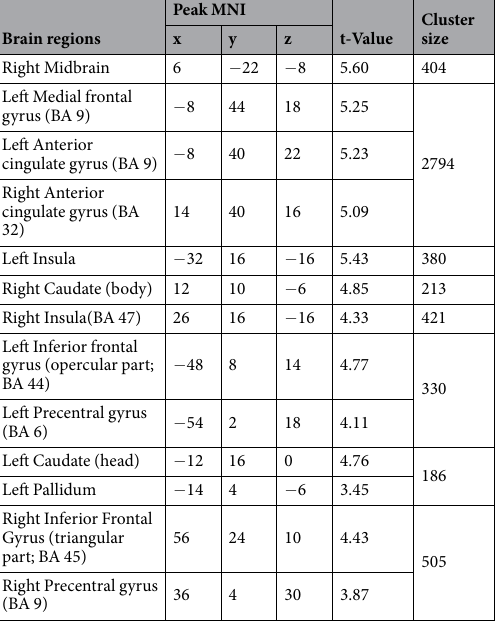
Table 2. Brain regions showing greater activation in choices of a slightly selfish offer (i.e., offering 40% or 30%) than a fair offer ( p < 0.001 uncorrected with FDR correction at the cluster level; BA, Brodmann’s